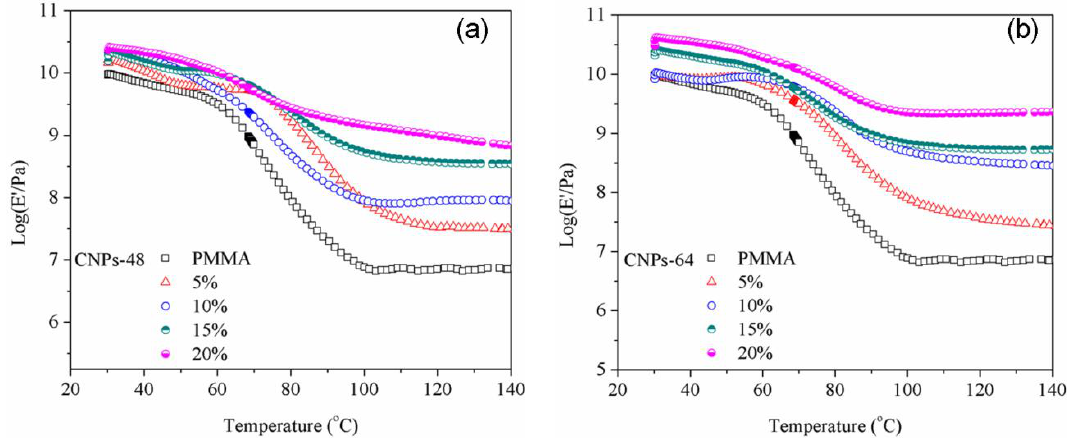
Figure 8. Temperature dependence of storage modulus ( E ′) for PMMA